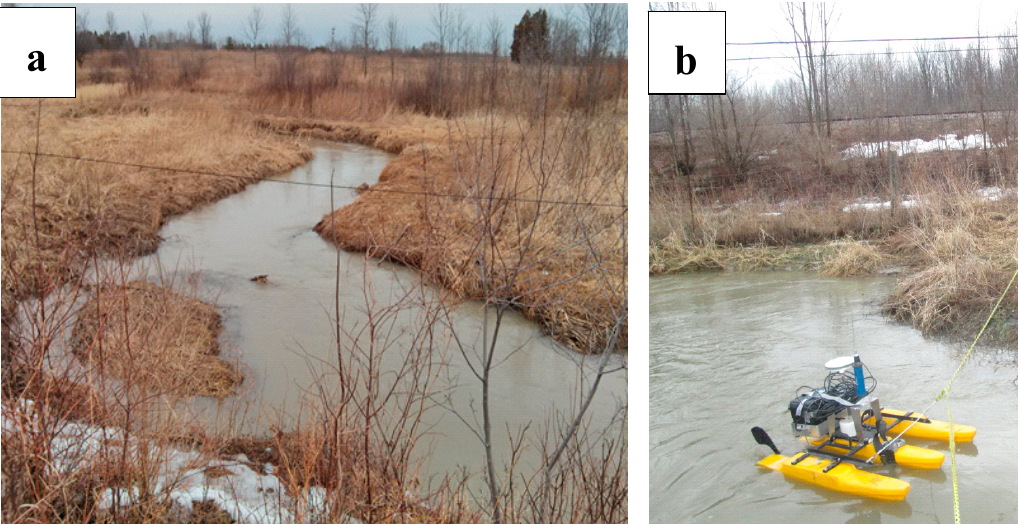
Figure 4. M4 sampling reach: ( a ) meander bend restrained by the City of Ottawa rail, facing upstream. Formation of the longitudinal bar and the secondary channel on the upstream of the outer bend apex; ( b ) ADCP spatial survey in the study reach. The City of Ottawa rail line can be seen immediately adjacent to the south of the river. Pictures were taken by the authors on 14 April 2015.